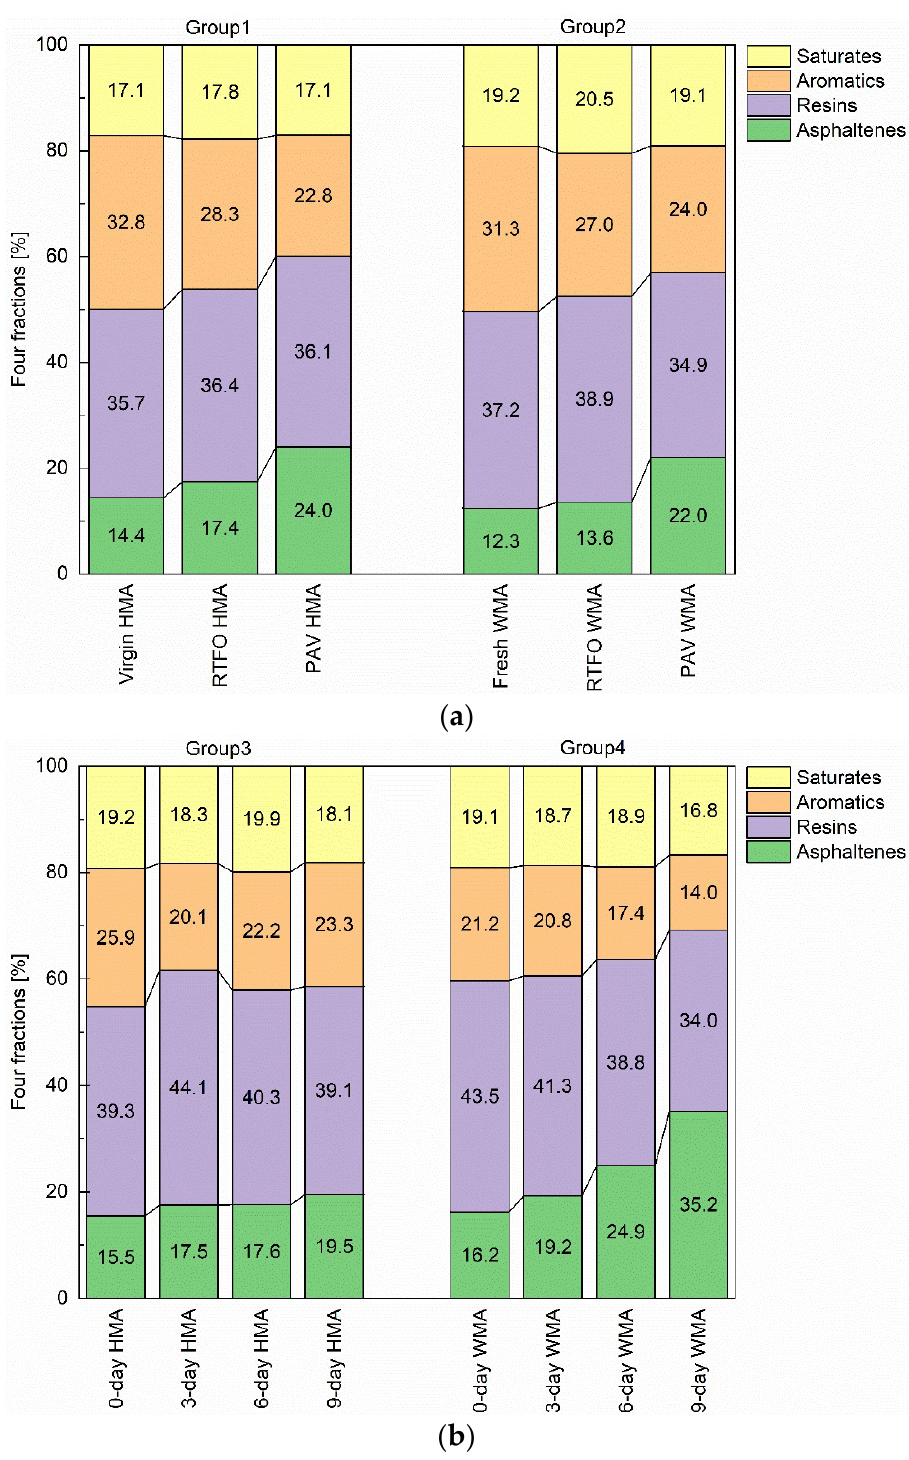
Figure 11. Change in four fractions of all binder as a function of ageing. ( a ) for groups 1, 2, and ( b ) for groups 3 and 4.